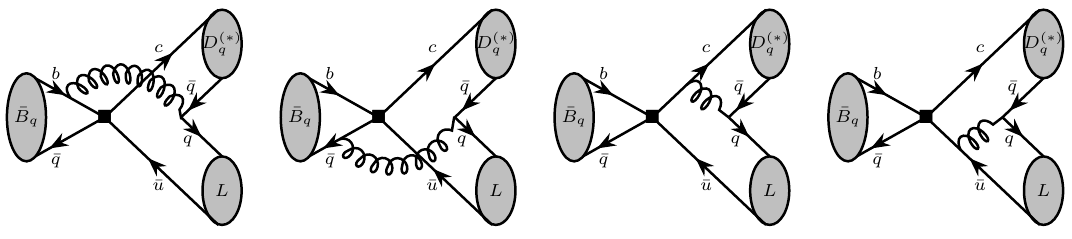
→ D ( ∗ )+ L − decays at O ( α s ) . ( s ) ( s )